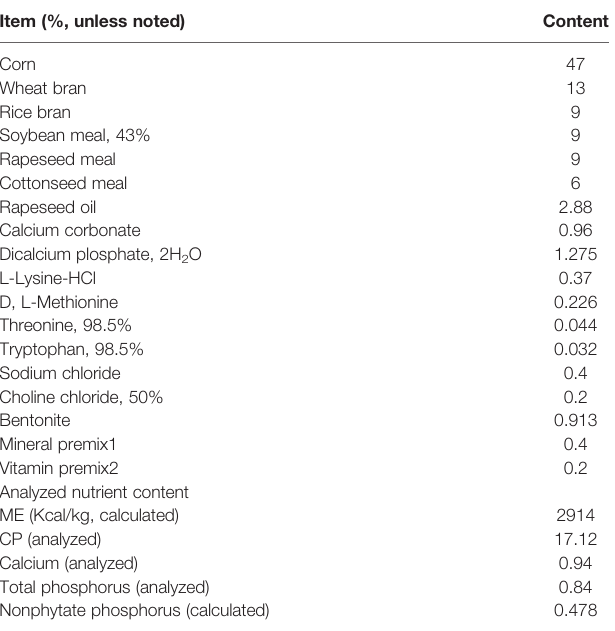
TABLE 1 | The composition and nutritional levels of the basal